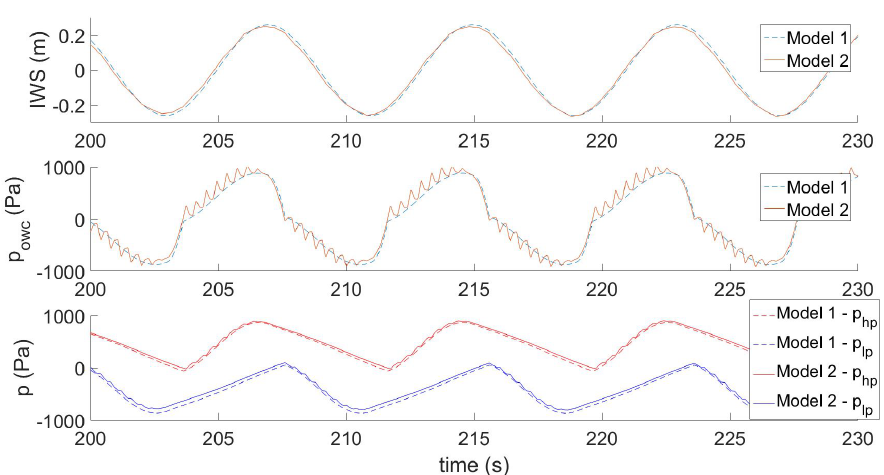
Figure 10. Internal Water Surface (IWS) elevation and excess pressures obtained in OWC, HP and LP chambers obtained by Numerical Models 1 and 2 for 2 m-high and 8 s-period regular